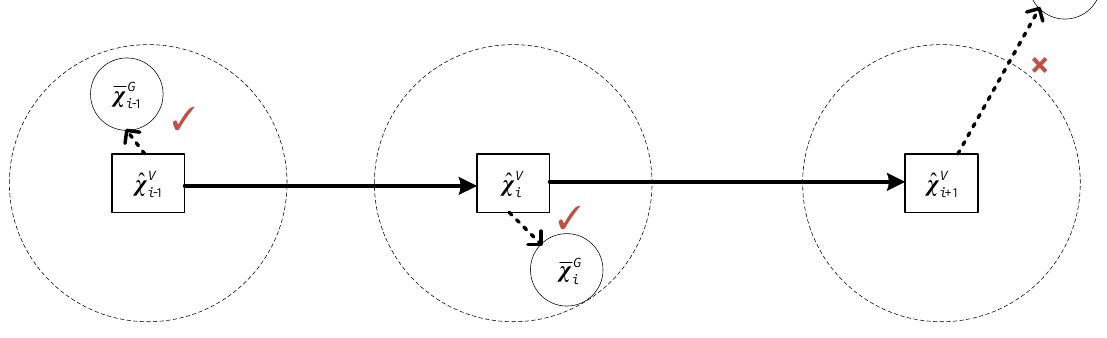
Figure 3. Localization Verification .